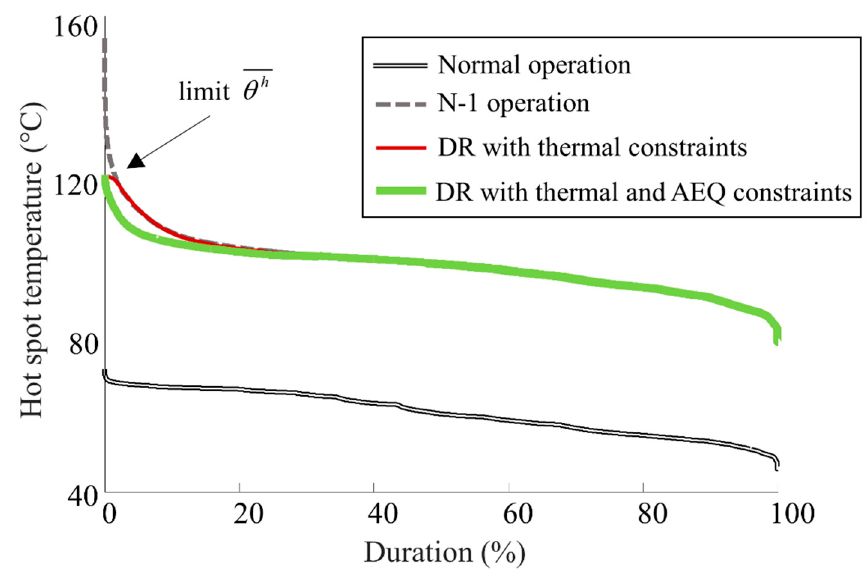
Figure 16. Yearly temperature duration curves: 75% reserve in “energy-shedding” mode leading to less than 1% energy curtailment, as seen in Figure 14d.